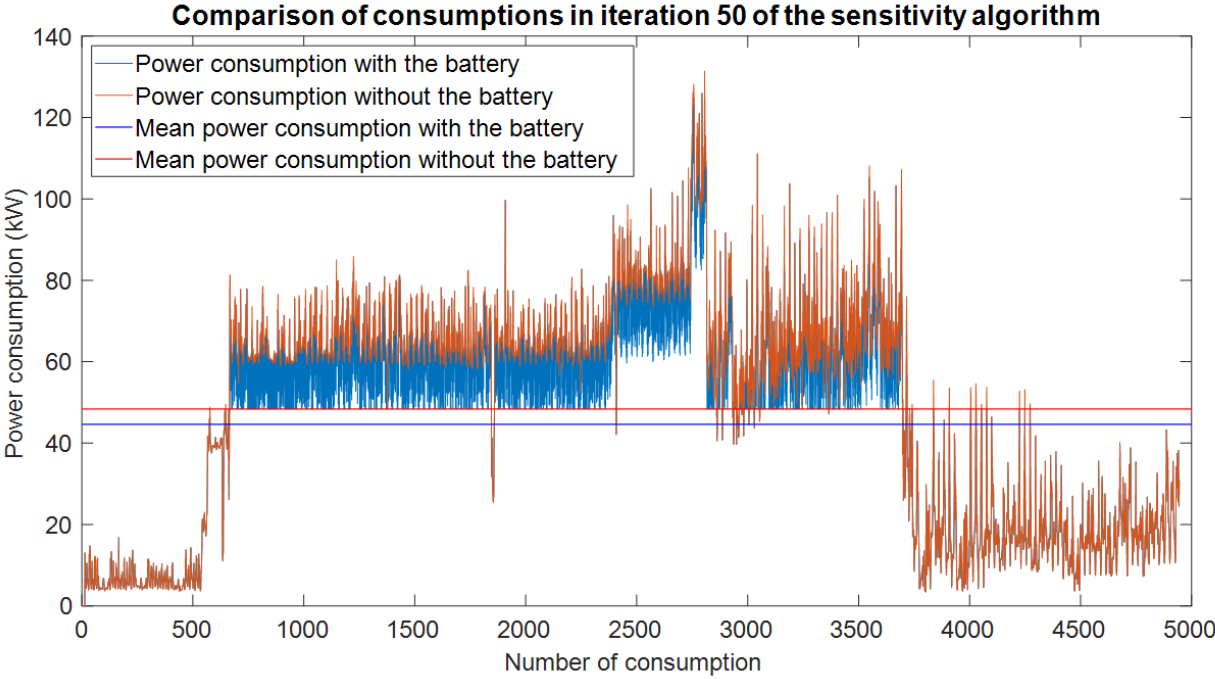
Figure 10. Power consumption (kW) comparison with and without the battery (iteration